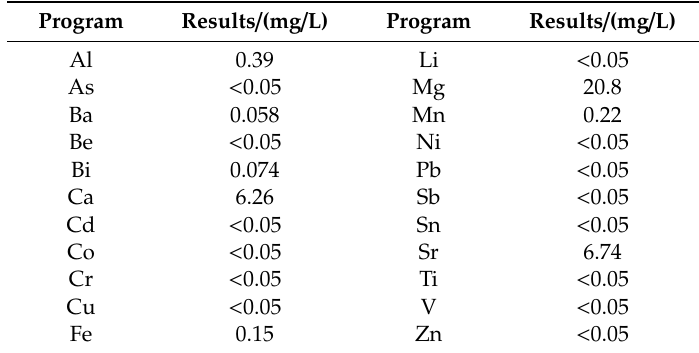
Table 4. Results of chemical element analysis of water.